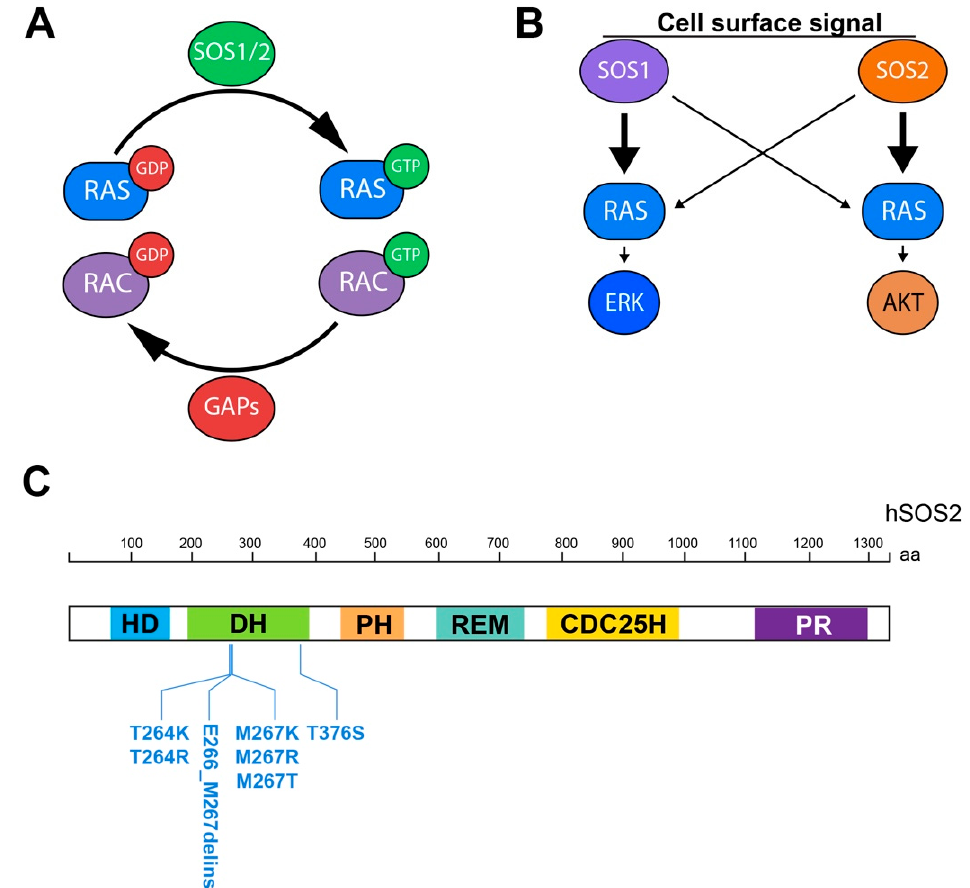
Figure 1. Functional relevance of SOS1/2 GEFs in physiological RAS signaling pathways and RASopathies. ( A ) Schematic representation of RAS and RAC activation/deactivation cycle mediated by SOS1/2 GEFs and GAPs, respectively. ( B ) Differential participation of SOS1 and SOS2 in downstream RAs signaling as suggested by current experimental evidence. ( C ) SOS2-specific mutational landscape in human RASopathies (Noonan syndrome, NS9 type). HD: histone domain; DH: Dbl homology; PH: pleckstrin homology; CDC25H: cell division cycle 25 homology; REM: RAS exchange motif; PR: proline-rich.